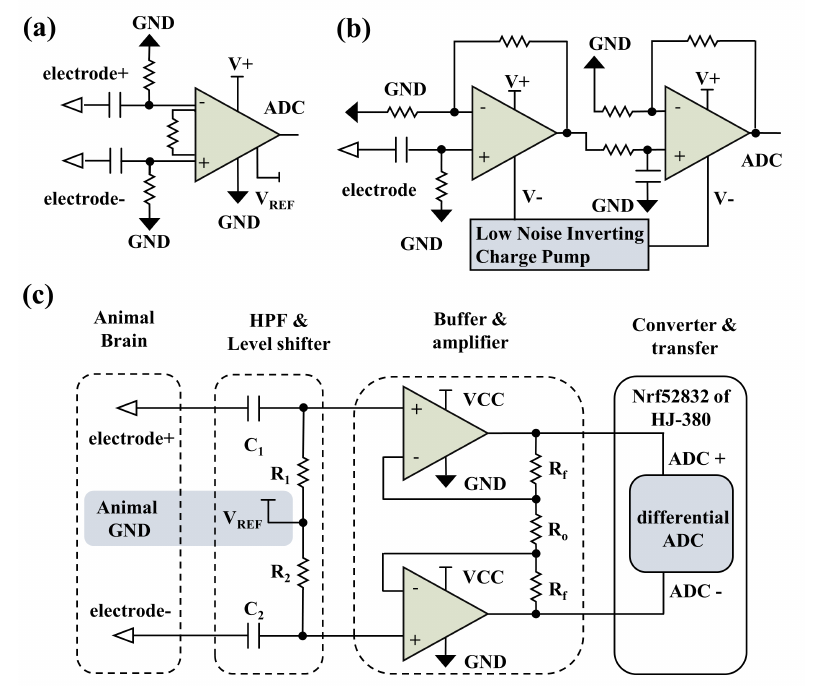
Figure 1. The comparison of front − end structures. ( a ) The front − end structure construction of instrumentation amplifier. ( b ) The front − end structure construction of cascade op − amps. ( c ) The dual op − amps full differential neural recording front − end structure we